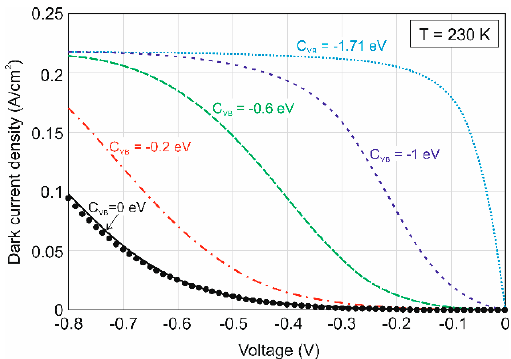
Figure 5. Measured (points) and calculated (lines) current-voltage characteristics for the nBn T2SL detector operated at 230